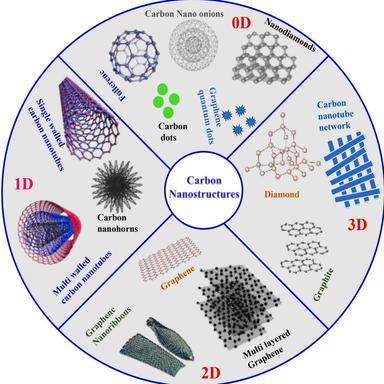
Classification of various carbon nanostructures.